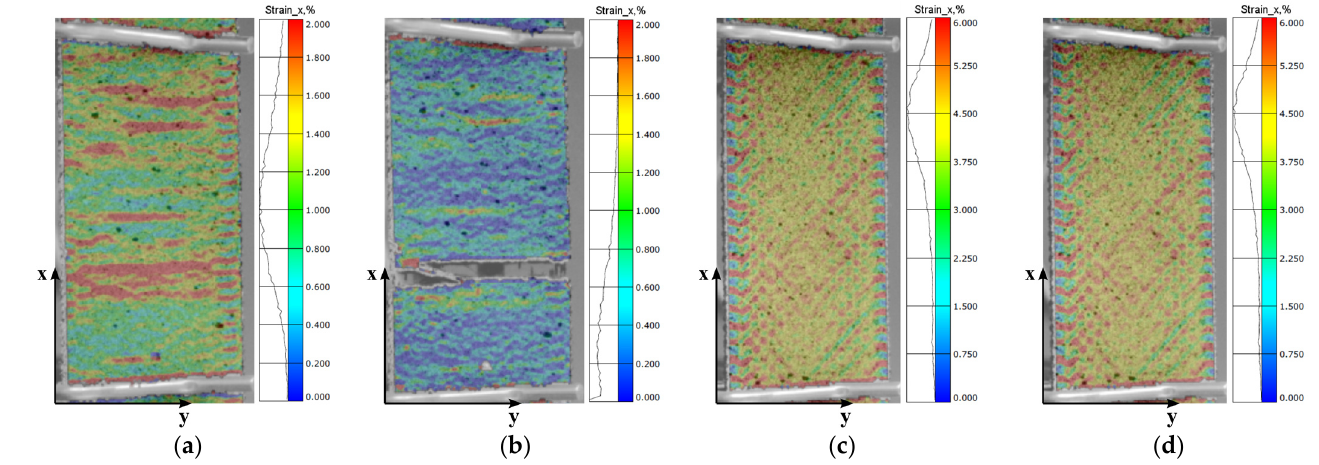
Figure 7. DIC images of the 50 mm gauge length during the experimental procedure: ( a ) UD-90 pre- failure, ( b ) UD-90 at failure, ( c ) SH-45 at 5% of shear strain, and ( d ) SH-45 at 5% of axial